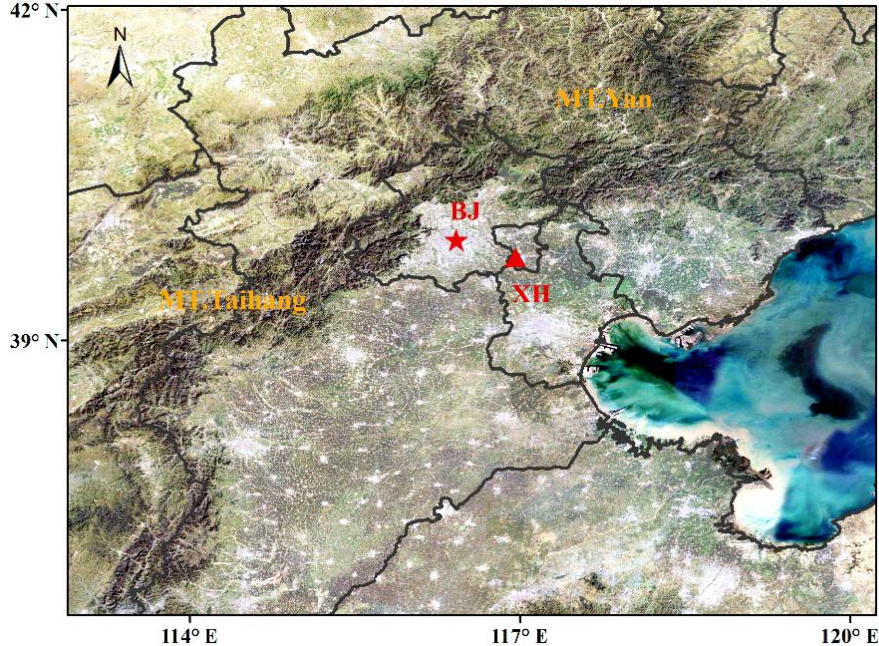
Figure 1. Topography overlapped with Beijing (BJ) and Xianghe (XH) Station (red triangle) in North China.